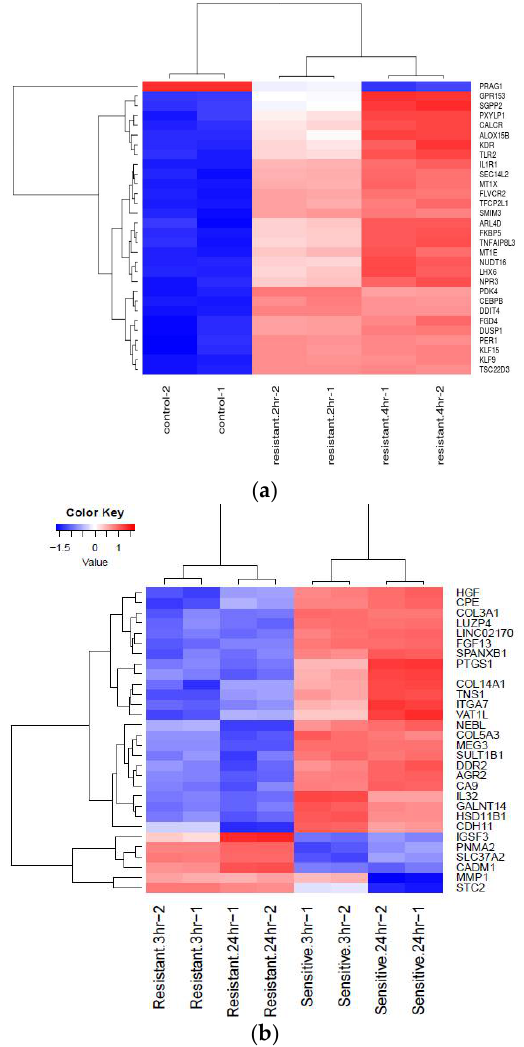
Figure 3. Heat maps: ( a ) For 24 h of JQ1 treatment; ( b ) For four hours of Dexamethasone treatment.